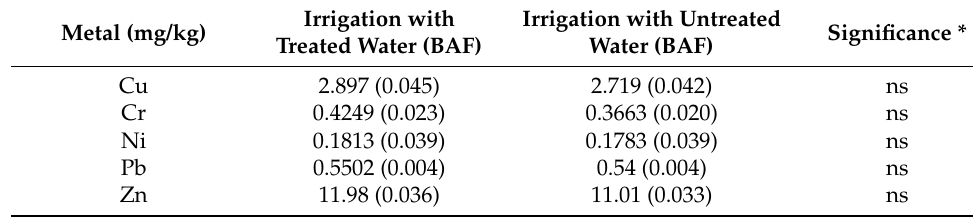
Table 1. Heavy metal content in beans ( Phaseolus vulgaris ).